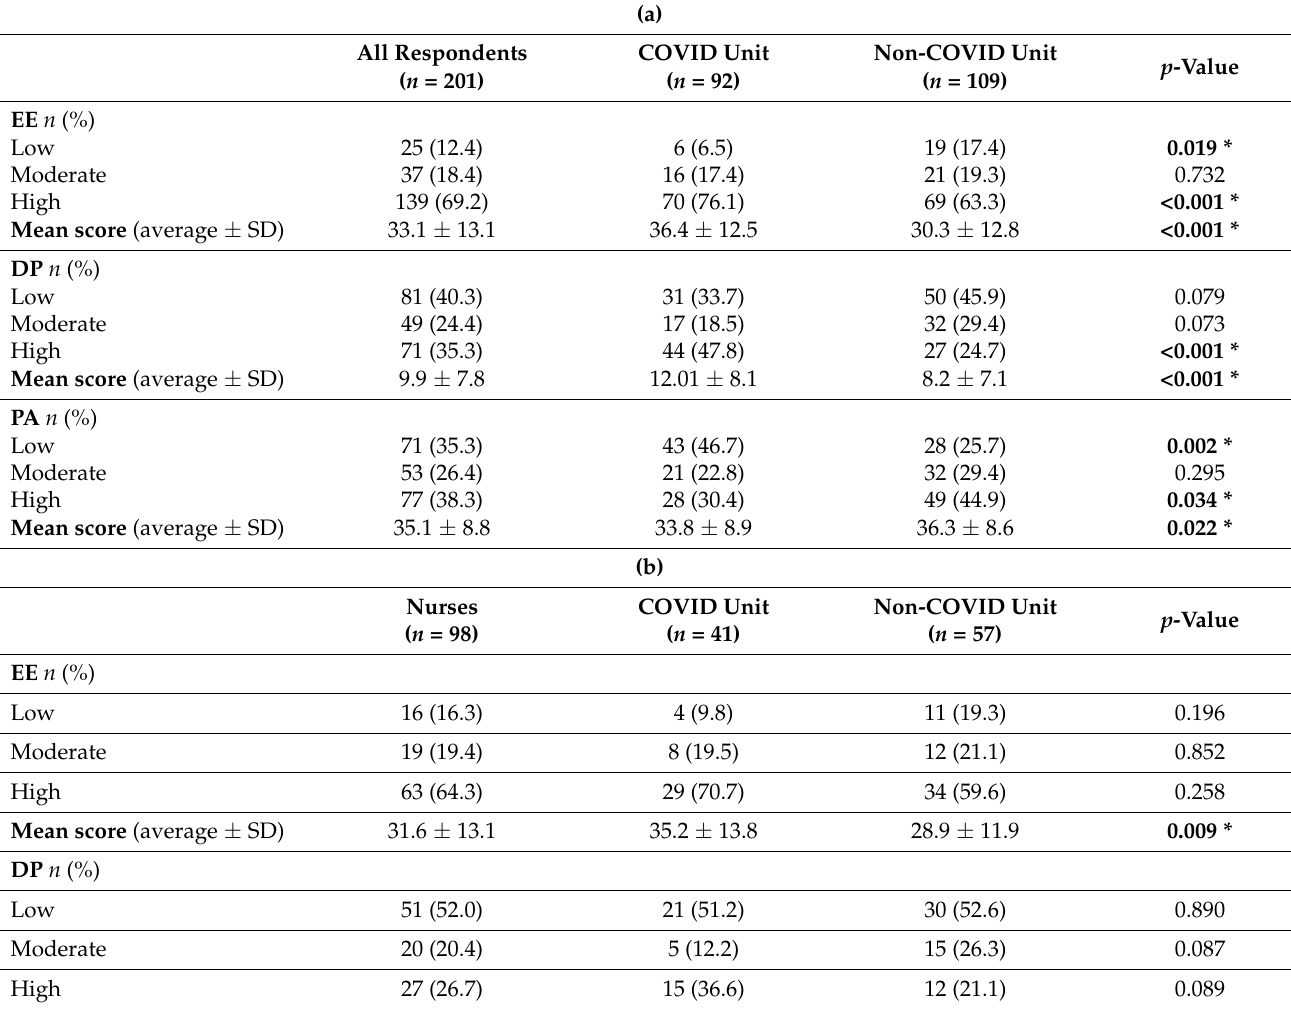
Table 3. ( a ) Levels of burnout syndrome according to the results of MBI-HSS: COVID and non-COVID unit. ( b ) Levels of burnout syndrome according to the results of MBI-HSS: COVID and non-COVID unit among